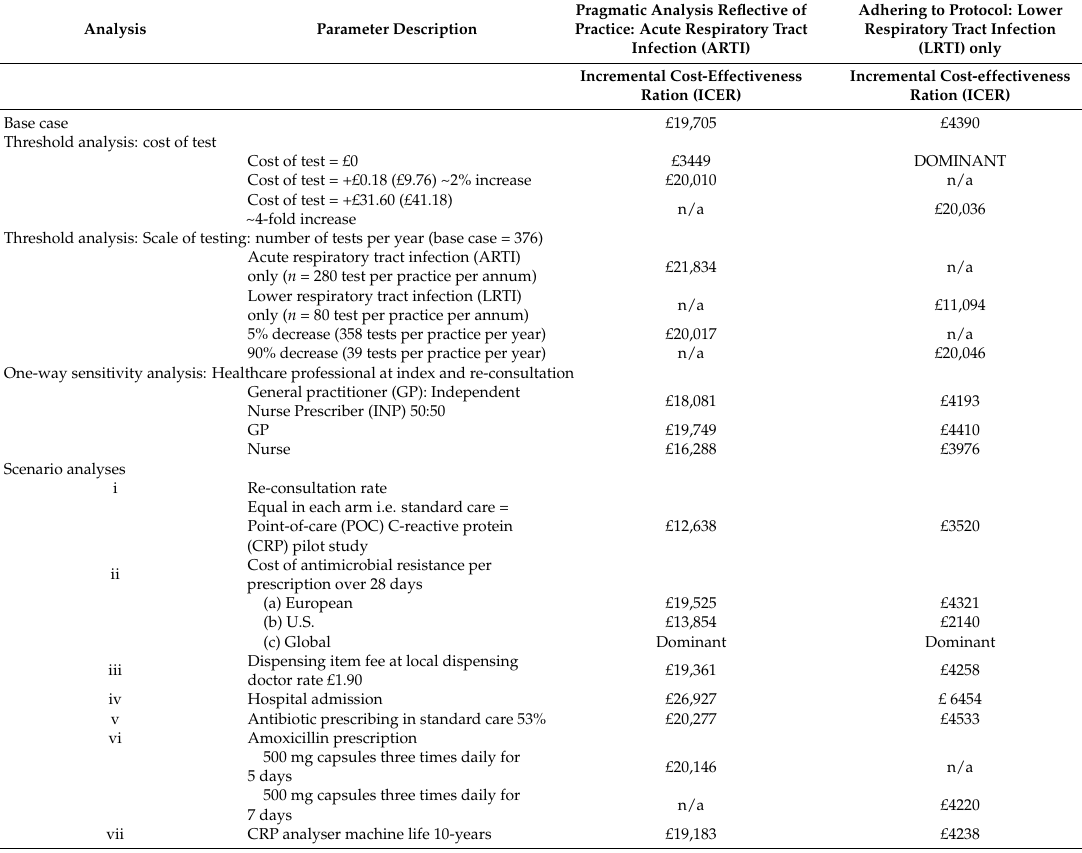
Table 2. Results of sensitivity and scenario analyses.